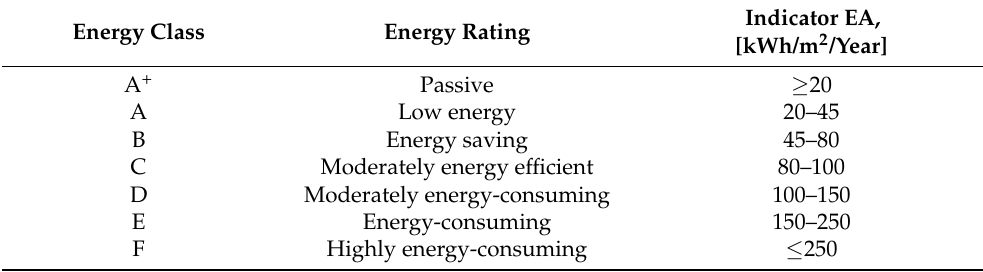
Table 2. Energy classification of buildings according to Association for Sustainable Development. Indicator EA, Energy Class Energy Rating [kWh/m 2 /Year] A + Passive ≥ 20 A Low energy 20–45 B Energy saving 45–80 C Moderately energy efficient 80–100 Moderately